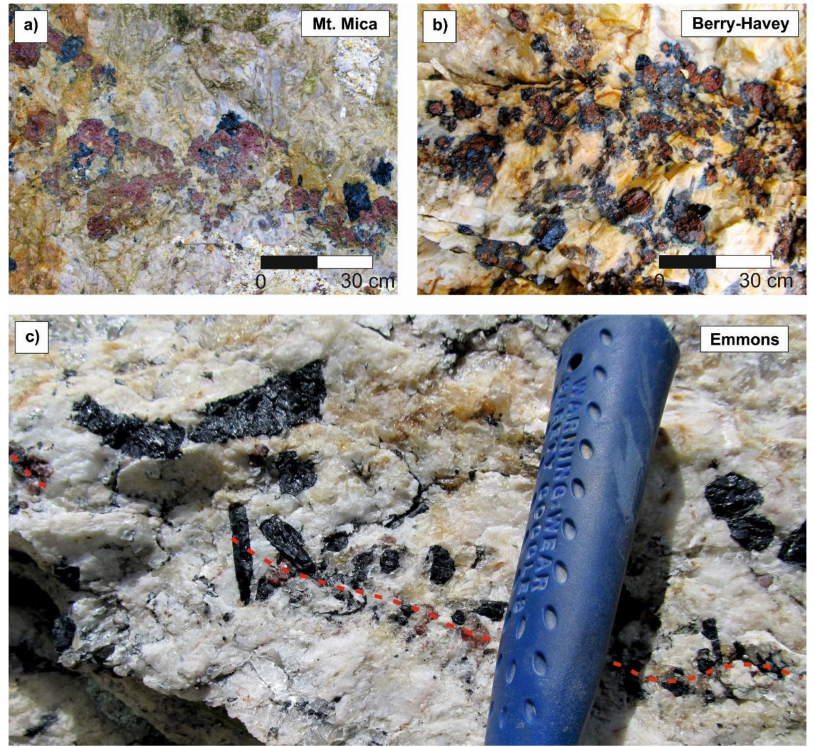
Figure 3. Garnet layer of three of the studied pegmatites from the Oxford field. Both Mt. Mica ( a ), and Berry-Havey ( b ), pegmatites show some garnets with tourmaline rims; ( c ) Garnet layer from the Emmons pegmatite (red dashed line) close to a schorl-rich